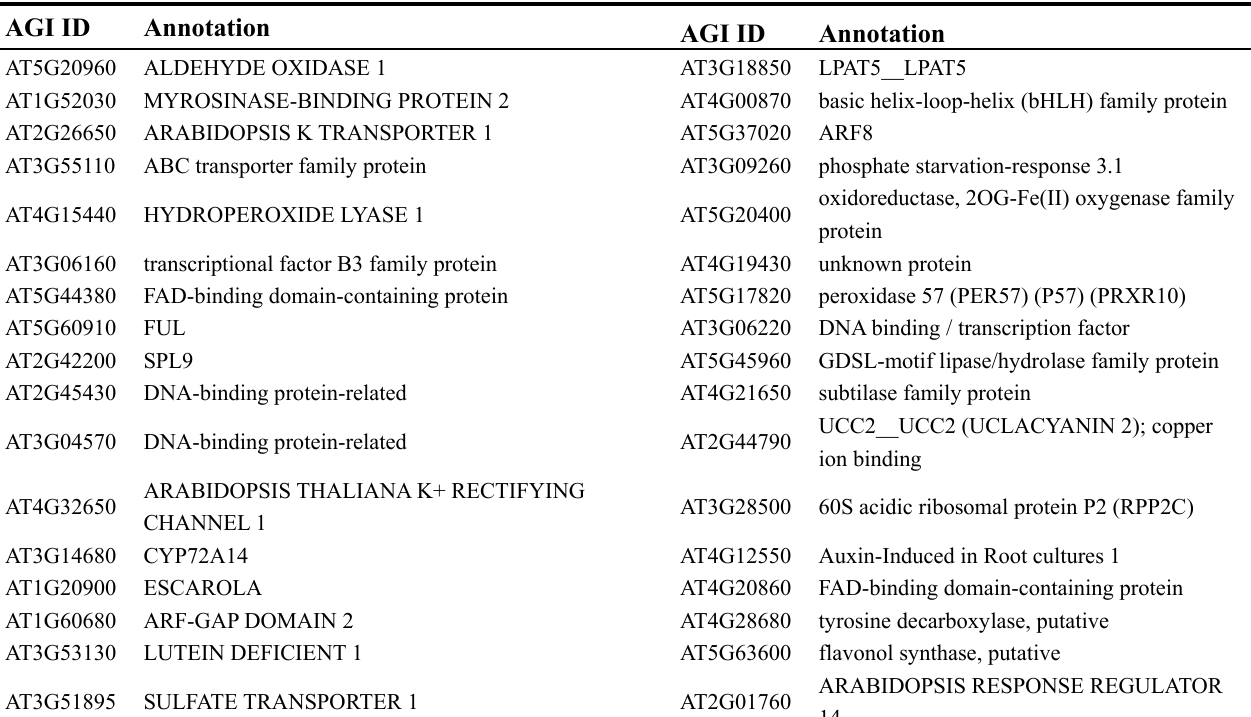
Table 1 . List of genes that are expression correlated with SPL in our